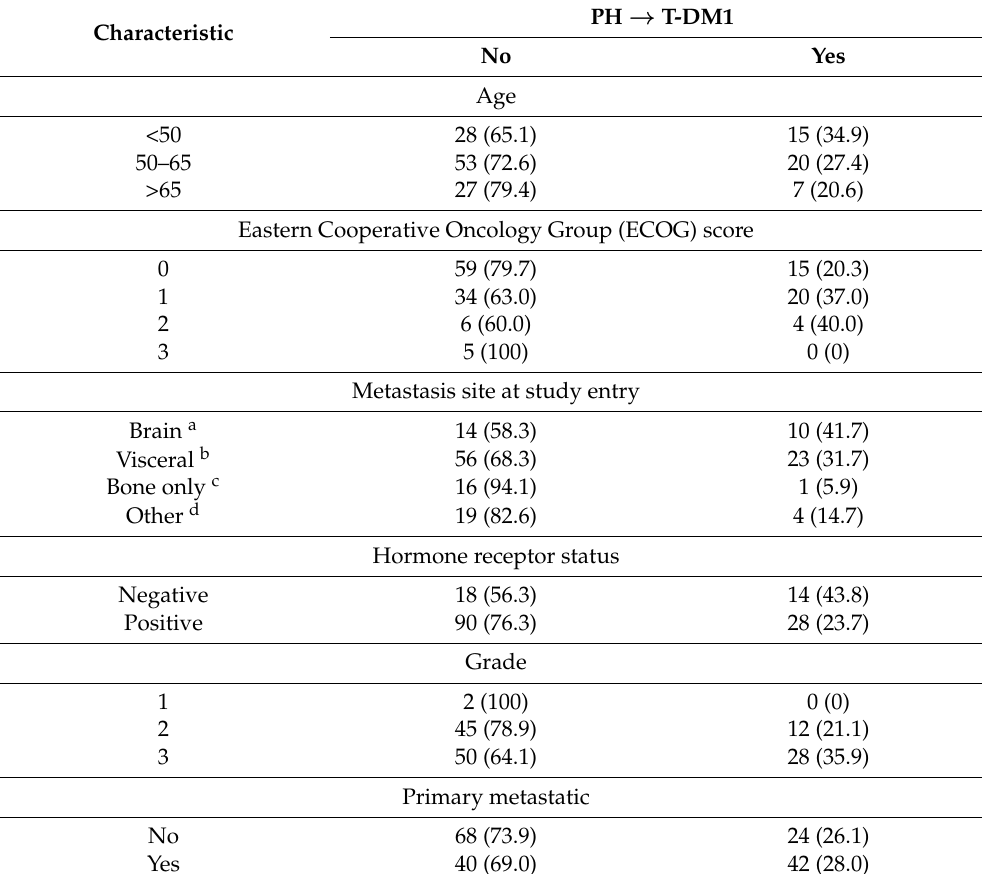
Table 4. Frequency of patients who received the treatment sequence pertuzumab/trastuzumab